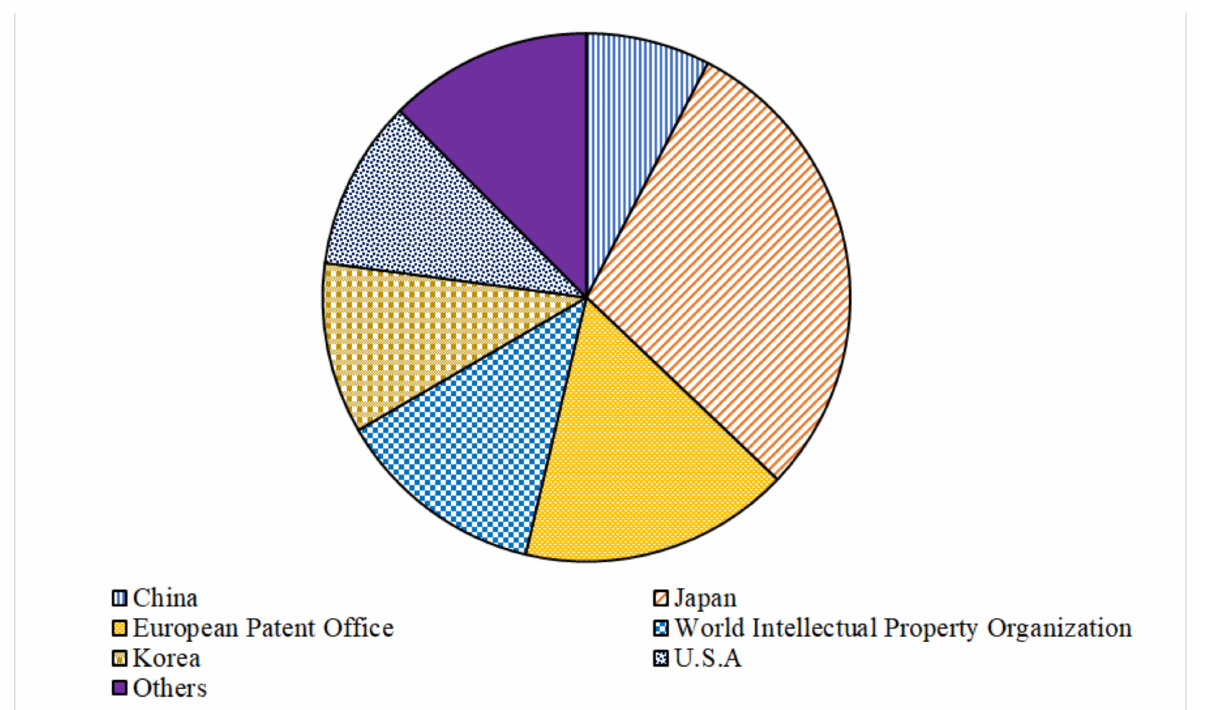
Figure 4. Patents of HVs from each country and